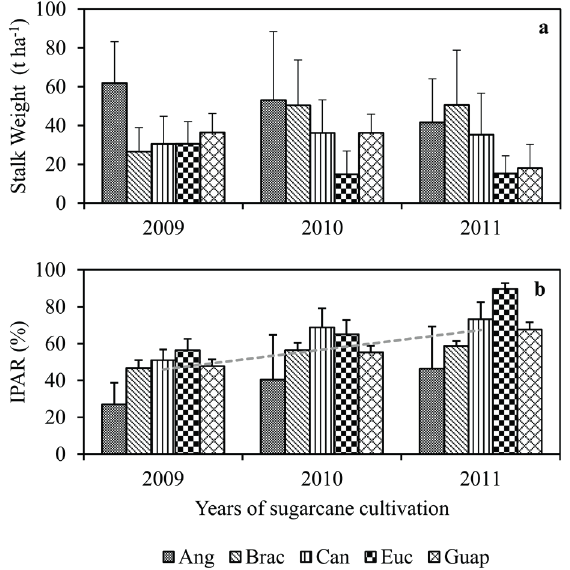
Figure 5 - Stalk weight ( a ) and Interception of photosynthetically active radiation – IPAR ( b ), of sugarcane grown in the understory of various tree species from 2009 to 2011, in Frederico Westphalen - RS. Bars indicate the standard deviation for each evaluation